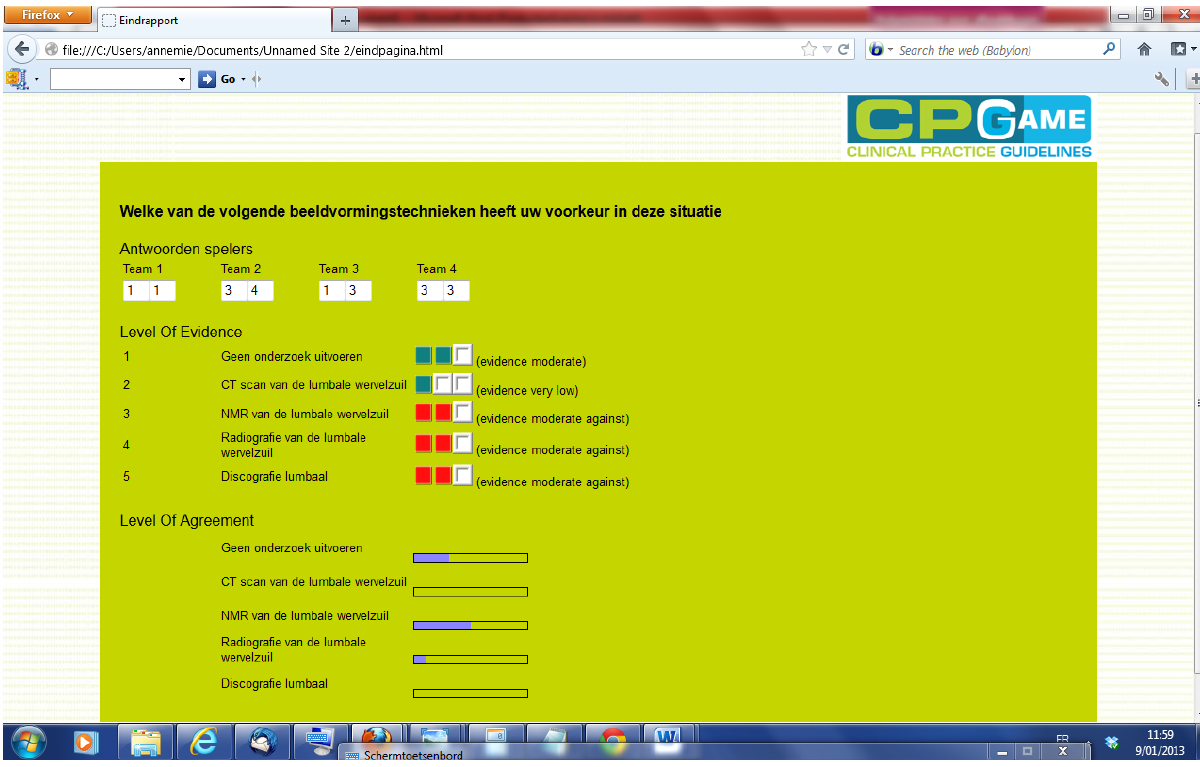
Figure 3. Screen capture of the final page in the CPGame application, showing the answers of all participants, the level of evidence, and the level of agreement between